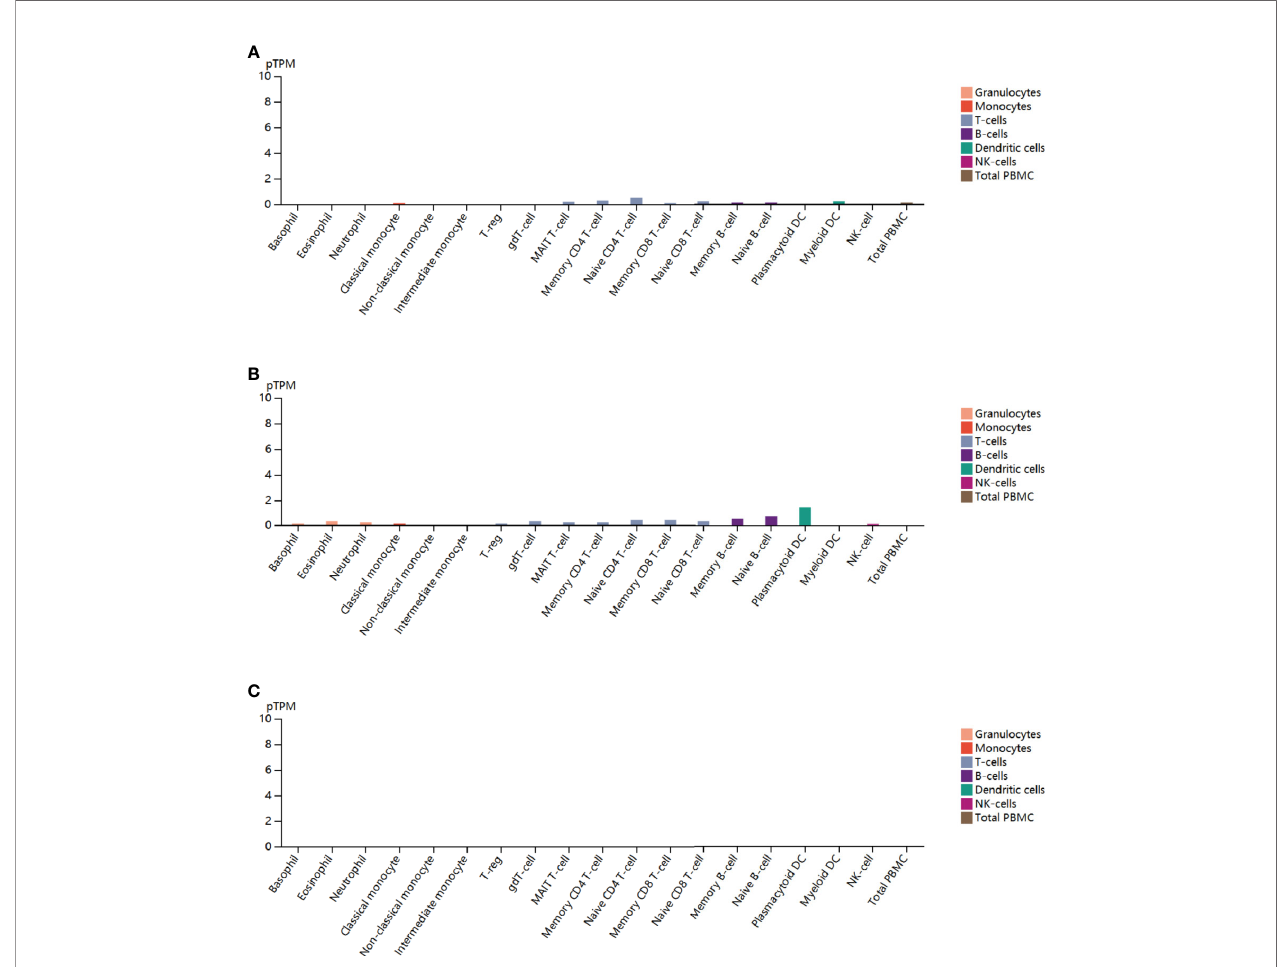
FIGURE 10 | Blood cell type-speci fi c expression pro fi le of ESR1 , ESR2 , and PGR across multiple cancer types. (A) Blood cell type-speci fi c distribution of ESR1 across multiple cancer types. (B) Blood cell type-speci fi c distribution of ESR2 across multiple cancer types. (C) Blood cell type-speci fi c distribution of PGR across multiple cancer types.